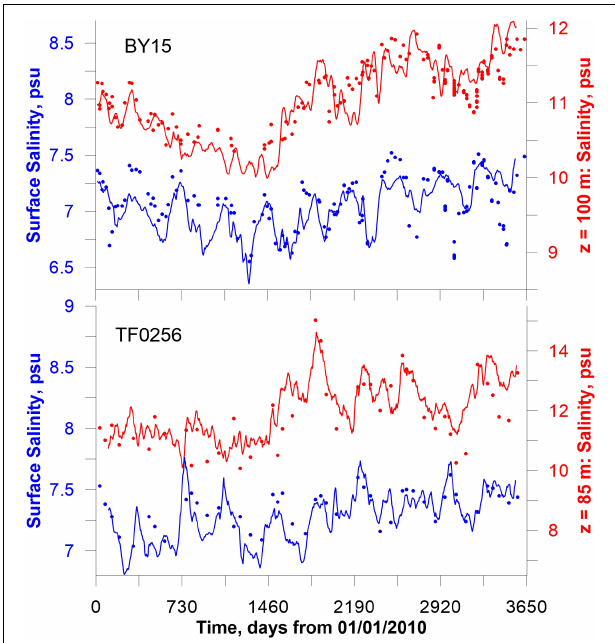
FIGURE 2 | Salinity time series at the sea surface (blue) and the permanent halocline / bottom layer (red) measured in the IOW monitoring station TF0256 (18.236 ◦ E, 55.326 ◦ N) and monitoring station BY15 in the Gotland Deep (dots) and simulated by the model (lines). The in situ data were taken from https://www.io-warnemuende.de/ (last access: 5 July 2021) and the Nest Institute’s BED (Baltic Environmental Database)